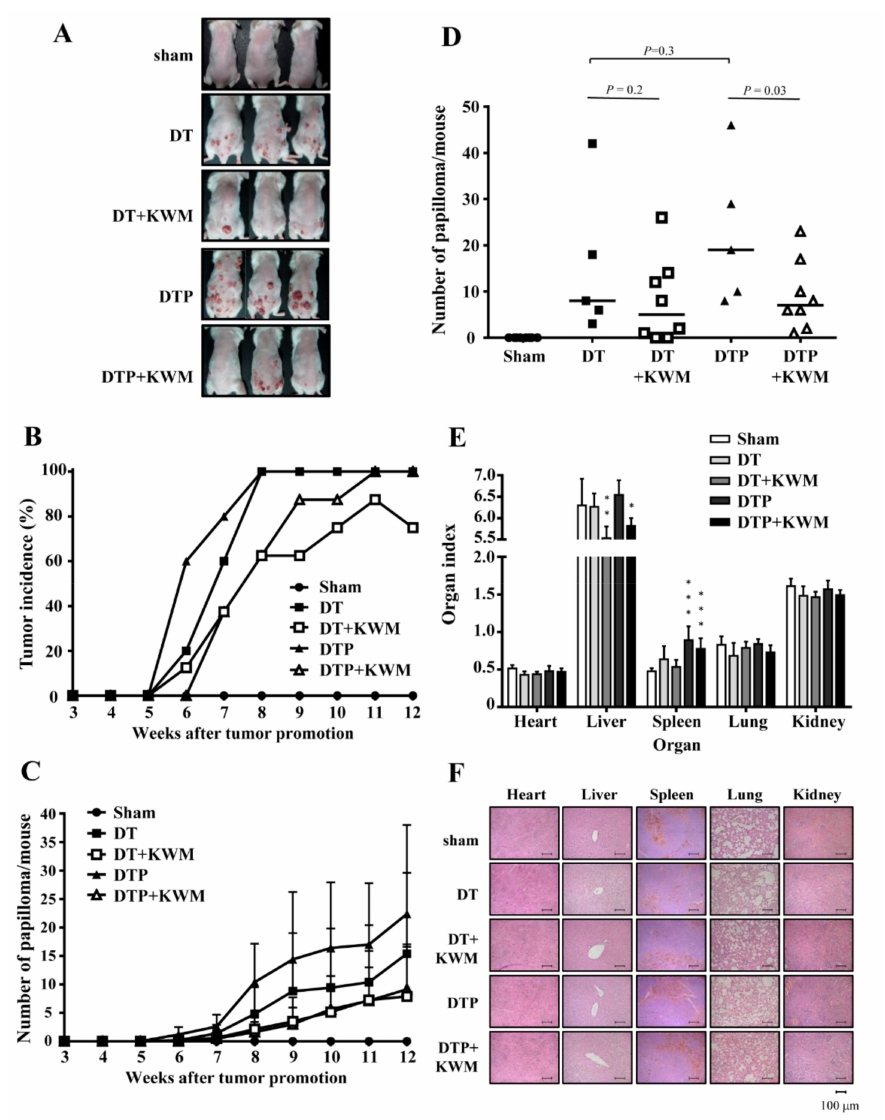
Figure 3. E ff ect of KWM-EO on two-stage skin carcinogenesis in mice. ( A ) Representative images of mice from each group at week 12 are shown. Tumor incidence ( B ) and mean number of papillomas ( C ) per group during the experimental period are calculated. ( D ) Papilloma numbers per mouse at week 12 are shown in the dot